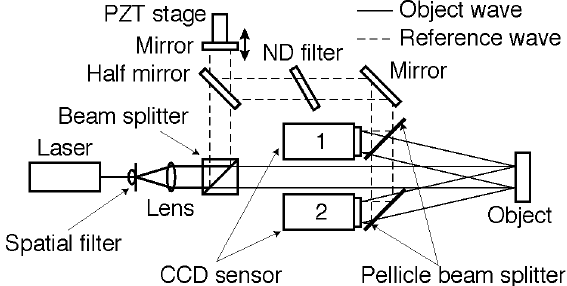
Fig. 6. Displacement and strain distribution measurement setup using two CCD